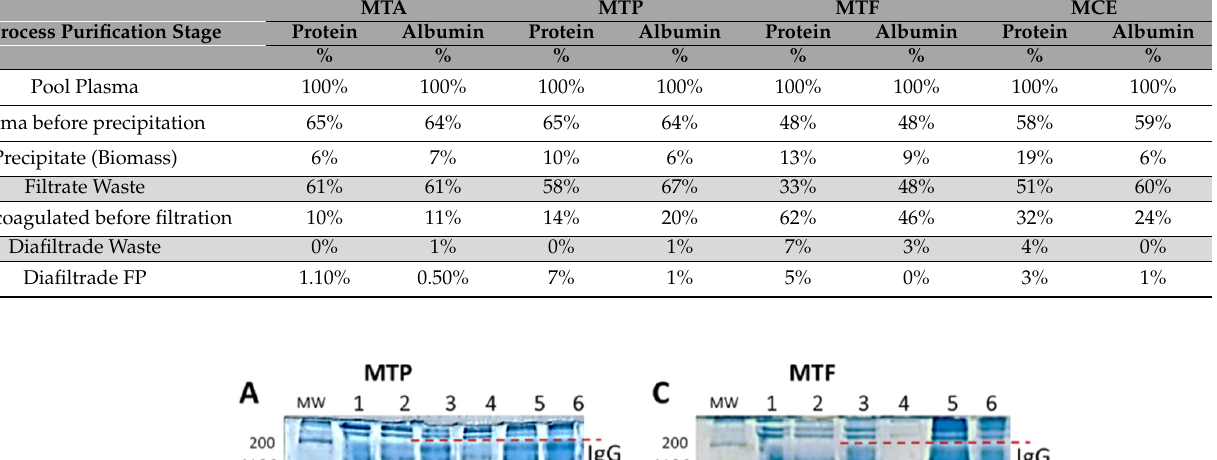
Table 3. Protein and albumin percentages on the different IgG purification stages from each mono- valent antigen batch. F.P.: Final Product. M.T.A.: Tityus asthenes monovalent batch; M.T.F.: Tityus fuhrmanni monovalent batch; MTP: Tityus pachyurus monovalent batch; M.C.E.: Centruroides spp. monovalent batch. Light gray shadow lines indicate the waste product of the process.